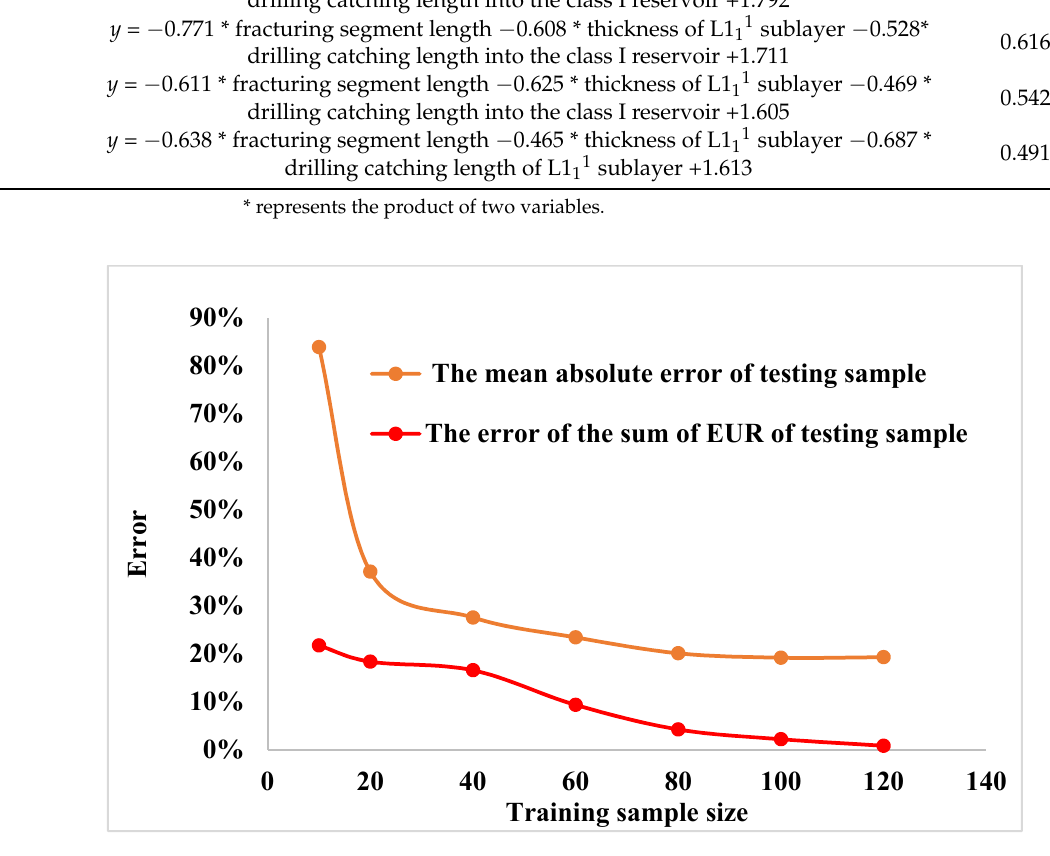
Figure 2. Model prediction results. Table 7. The prediction results of different schemes.